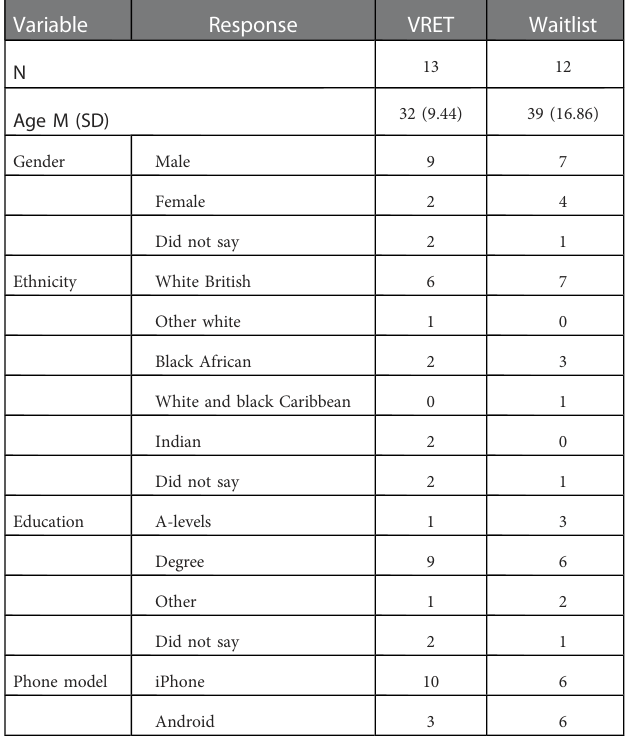
TABLE 1 Participant